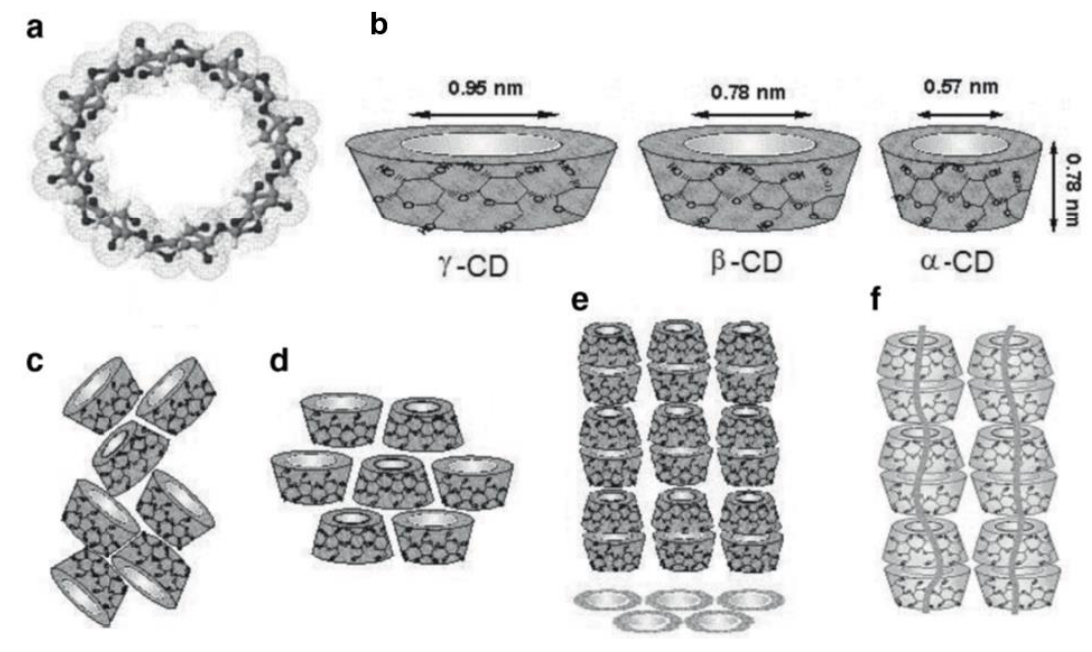
Figure 3. ( a ) γ -cyclodextrin (CD) chemical structure and ( b ) approximate dimensions of α -, β -, and γ -CDs; schematic representation of packing structures of ( c ) cage-type, ( d ) layer-type, and ( e ) head-to-tail channel type CD crystals; and ( f ) CD–IC channels containing included polymer guests. Reproduced with permission from [15]. Copyright 2009 Springer.